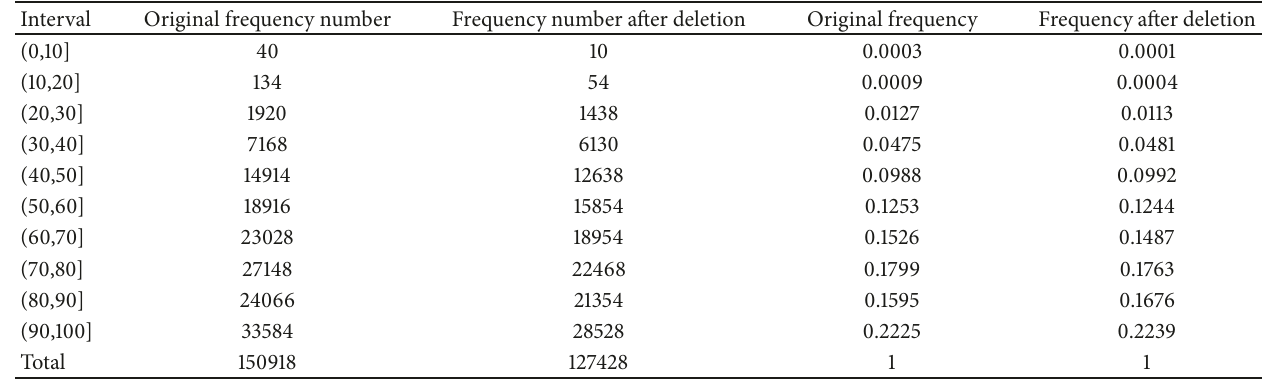
Table 1: Statistical comparison of SOC before and after deletion